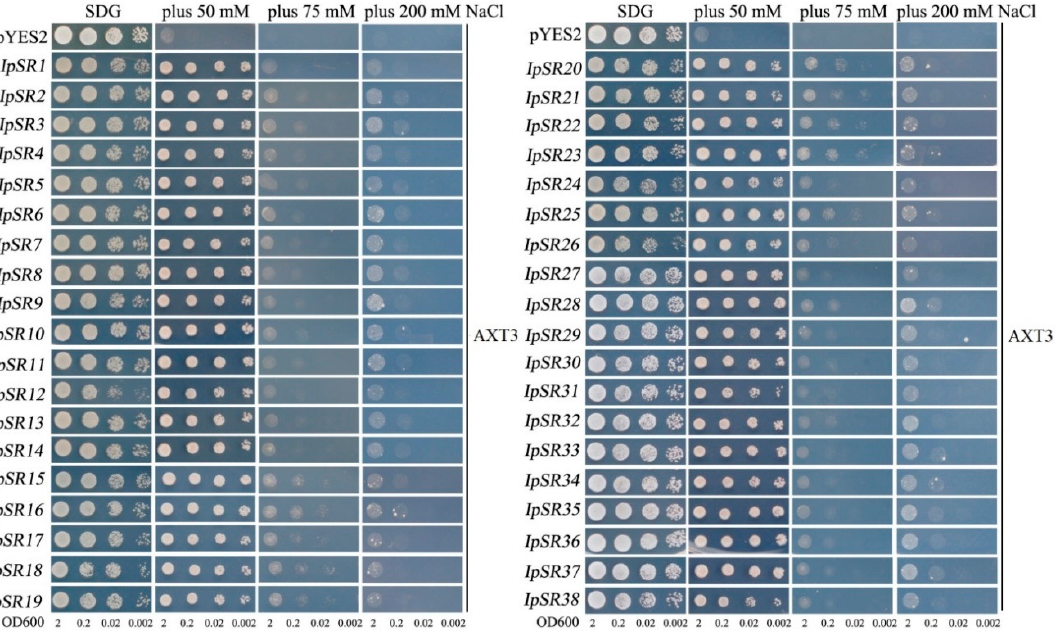
Figure 3. Salinity-tolerance confirmations in the yeast salt-sensitive mutant AXT3 of 38 clones ( IpSR1 to 38 ) via library screening from I. pes-caprae . The yeast cultures (OD600 to 2) were serially diluted to OD600 values of 0.2, 0.02, and 0.002, and then 2 µ L of yeast liquid was spotted onto SDG-Ura (supplied with adenine for AXT3) plates with or without NaCl (0, 50, 75, and 200 mM NaCl) for 5–10 days. The empty vector pYES2 represents the negative control.